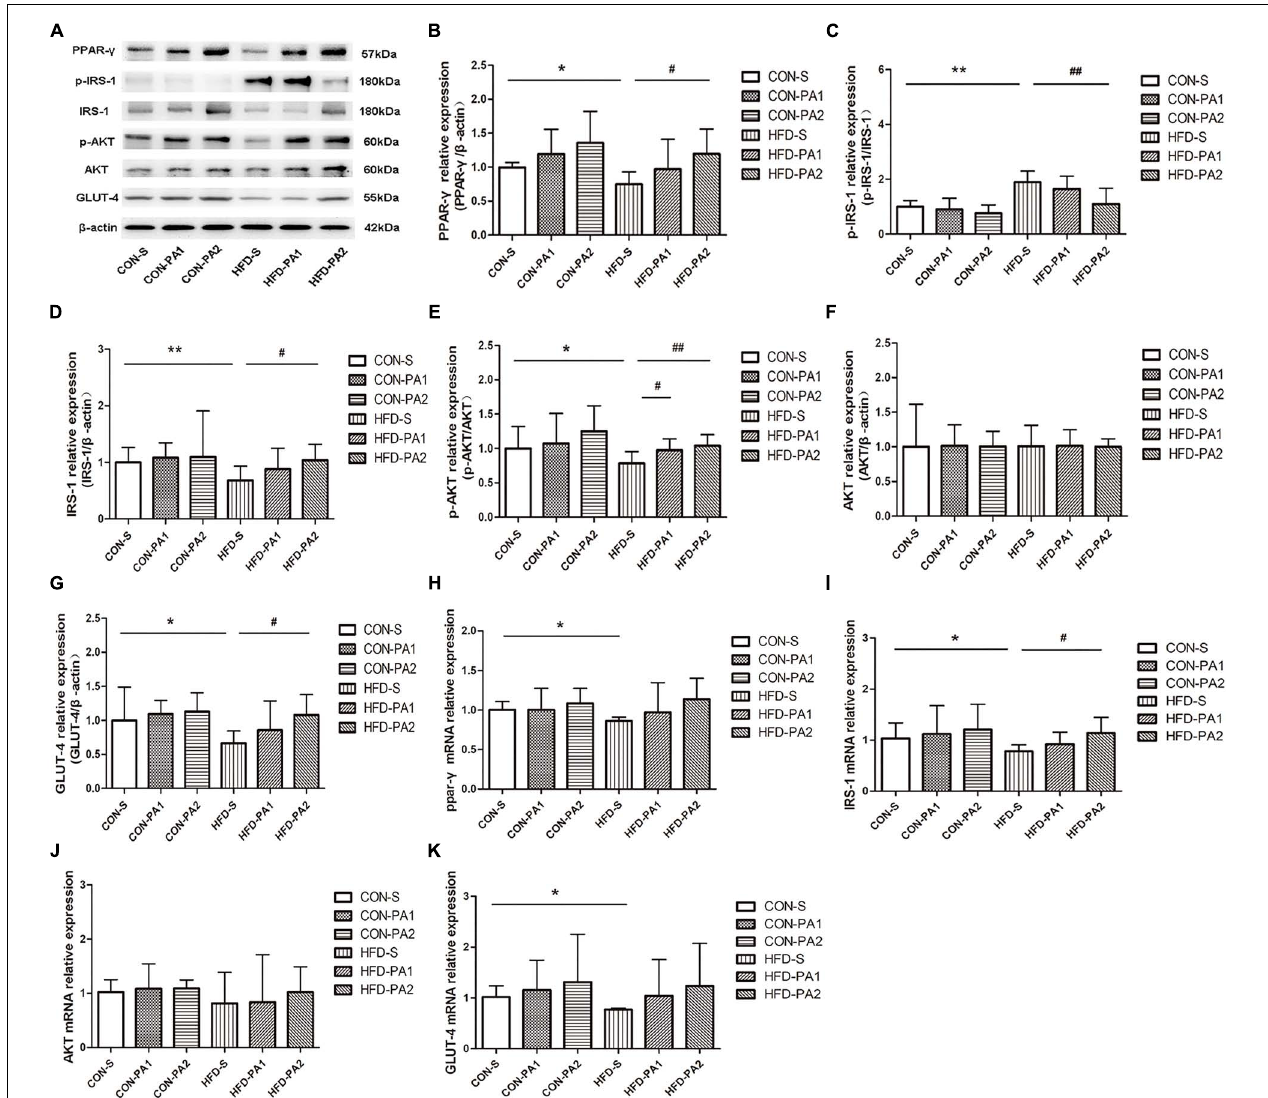
FIGURE 6 | Expressions of glucose uptake-related proteins in skeletal muscles of mice. (A–G) Western blot analysis of proteins PPAR- γ , p-IRS-1, IRS-1, p-AKT, AKT, and GLUT-4 in skeletal muscles of mice. Compared with the CON-S group, * P < 0.05 and ** P < 0.01; compared with the HFD-S group, # P < 0.05 and ## P < 0.01; comparison between exercise groups (CON-PA1 vs. CON-PA2, HFD-PA1 vs.